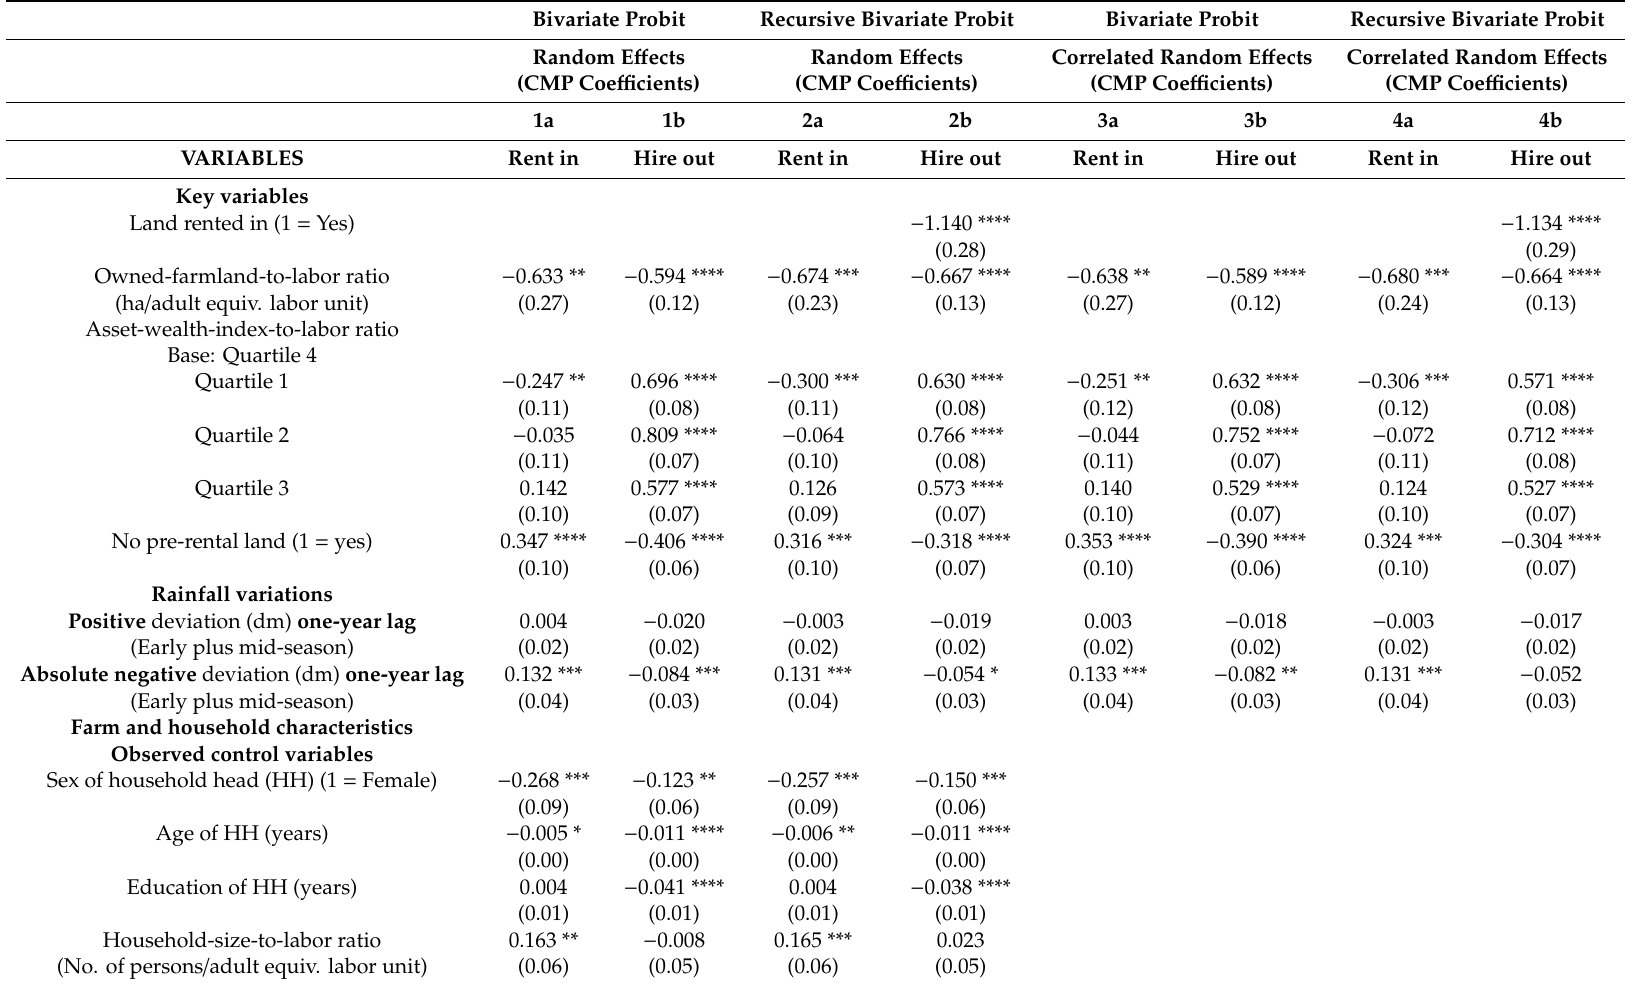
Table A3. Coe ffi cients of the bivariate probit model with conditional mixed process (CMP) for land rental and casual labor ( ganyu ) market